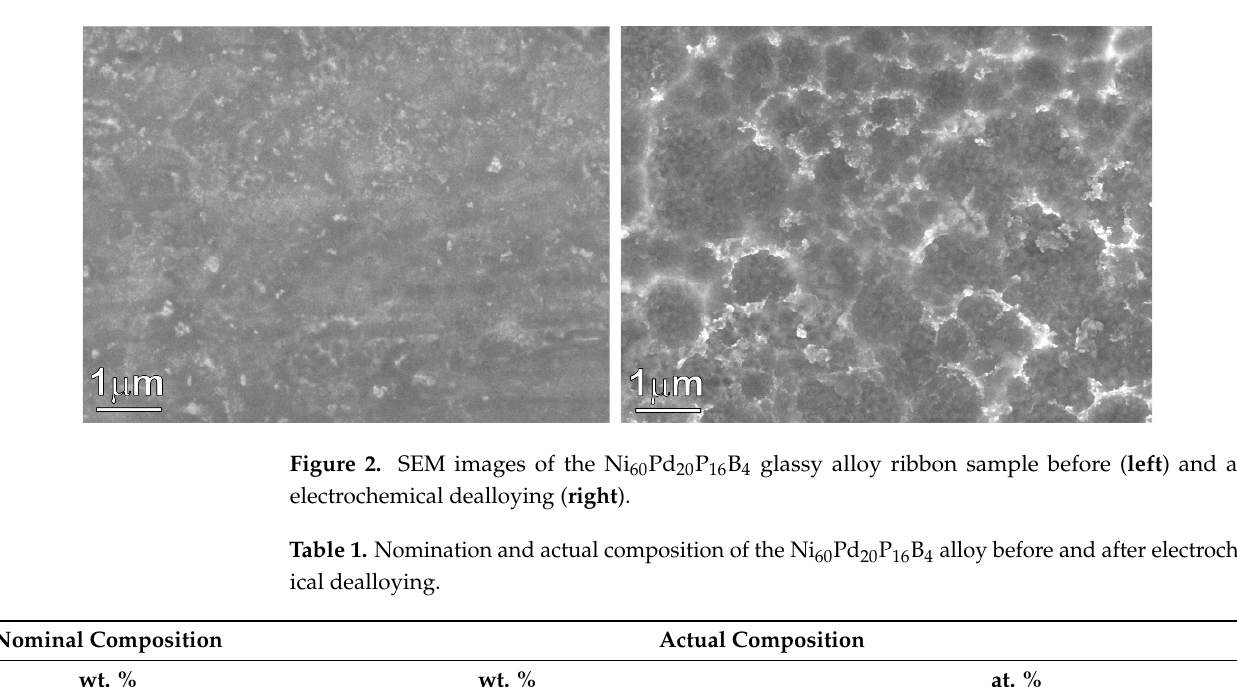
Figure 1. XRD pattern of the Ni 60 Pd 20 P 16 B 4 glassy alloy ribbon sample. The inset shows photo images of the ribbon sample before and after the dealloying experiment.